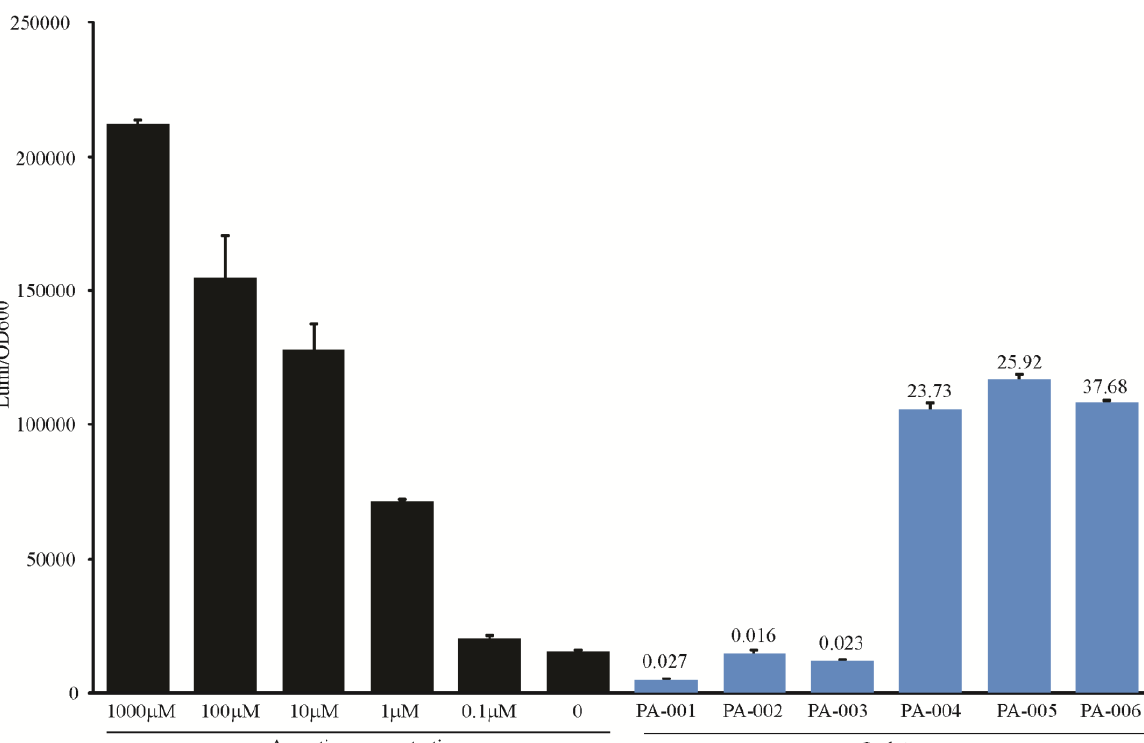
Figure 5. Detection of agmatine secretion in clinical isolates. The agmatine biosensor was grown in LB media with the indicated amount of agmatine, or grown in 50% LB and 50% spent supernatant from a 24 h liquid culture of clinical isolates. The y-axis represents the relative luminescence/OD 600 of each well after 3 h growth. Values above the bars representing spent supernatants are agmatine concentrations of those supernatants as determined by UPLC-MS/MS in micromolar. Error bars are SEM of three